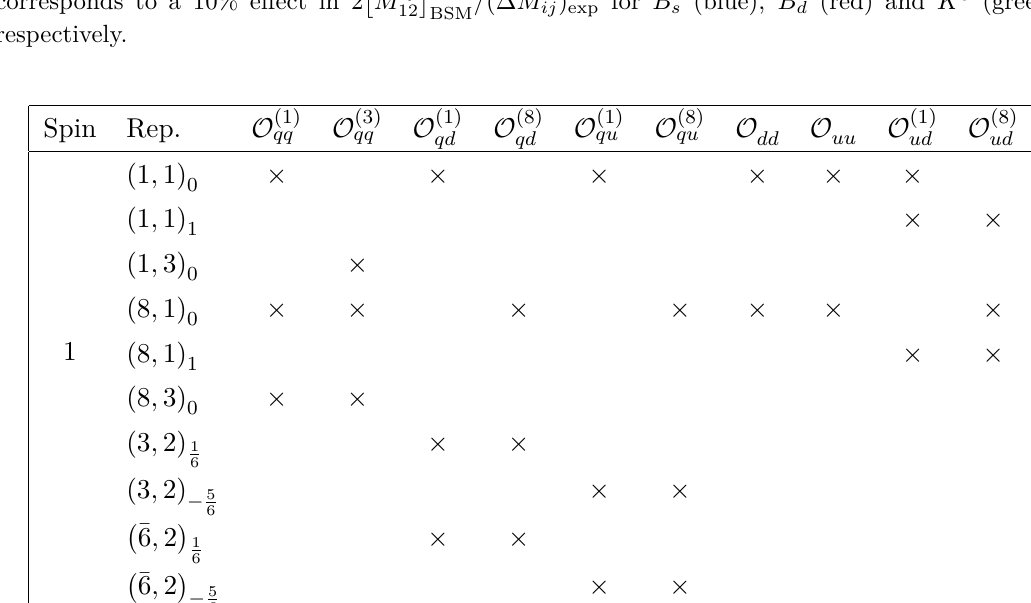
(cid:2) (cid:3) c (1) = 10 (lower) that ud ijkl